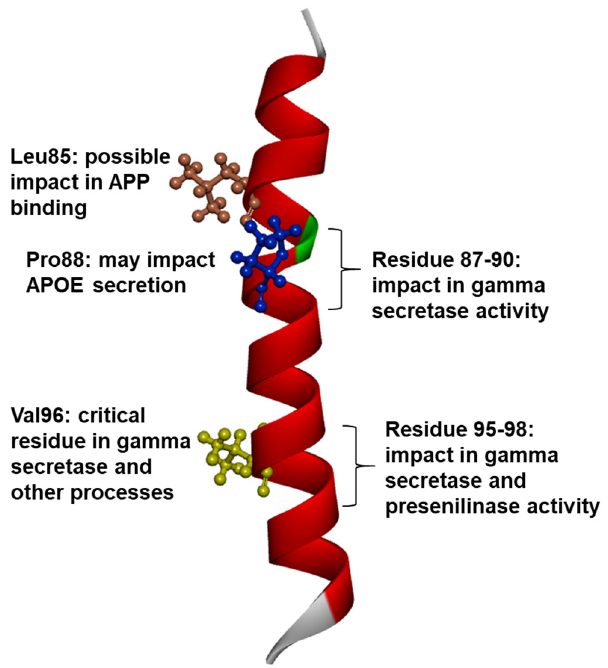
Figure 3 . Significant residues in PSN1 TM1 . Figure 3. Significant residues in PSN1